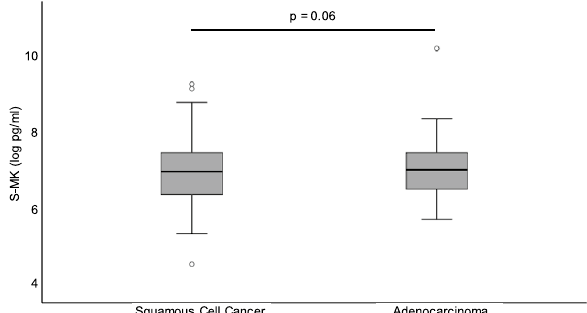
Figure 3. No difference in S-MK concentration between adenocarcinoma and squamous cell cancer. Abbreviations: S-MK serum-midkine, pg picogram, ml milliliter. S-MK concentration was compared between NSCLC patients with adenocarcinoma and squamous cell cancer. Data are shown in a box-and-whisker plot (median, 25th and 75th percentile, range, extreme values outside the range). Statistical significance was evaluated using unpaired t-test, p = 0.58.